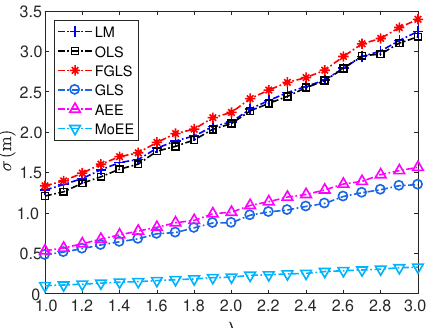
Fig. 1 Effects of measurement ranges with non-IID error.